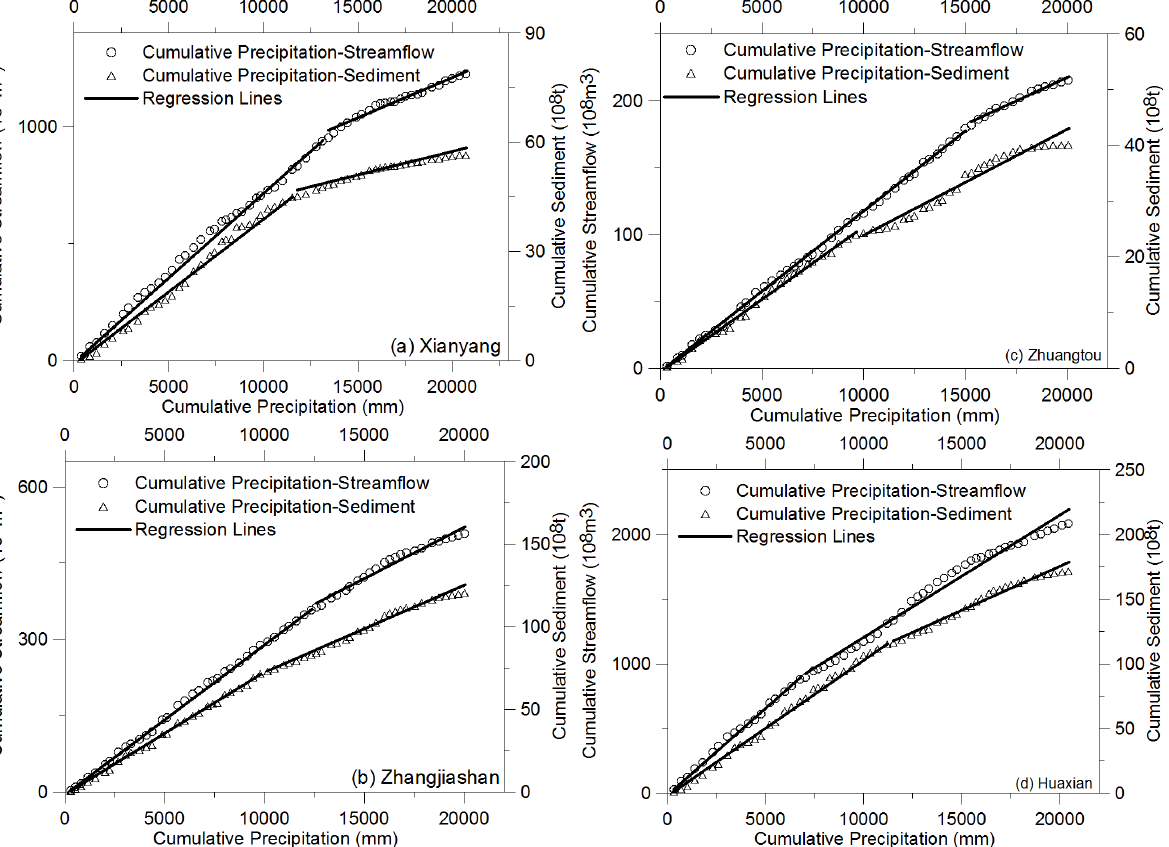
Fig. 5 Double mass curves of precipitation – stream flow and precipitation – sediment at: (a) Xianyang, (b) Zhanjiashan, (c) Zhuangtou and (d) Huaxian, in the Wei River basin. The straight lines are the regression lines for the cumulative data before and after change-point years.